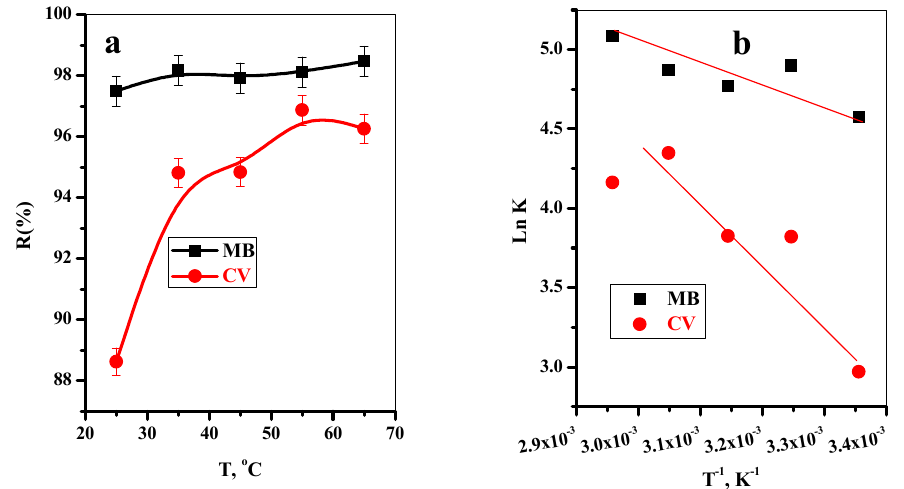
Figure 6. ( a ) Effect of temperature on the removal percentage of MB and CV dyes onto T-BC adsorbent, and ( b ) thermodynamic isotherm for the adsorption processes (t = 8 min for MB and 10 min for CV, (dye) = 30 mg/L, dose = 20 mg, pH = 7, T = 25 °C). Table 4. Thermodynamic parameters for the sorption of MB and CV onto T-BC.